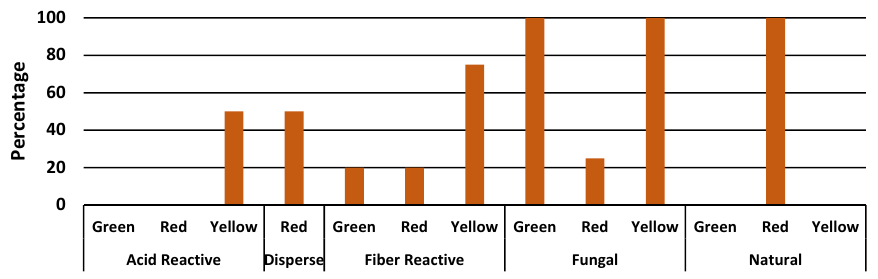
Figure 4. Results for colorfastness to dry crocking, mordanted.